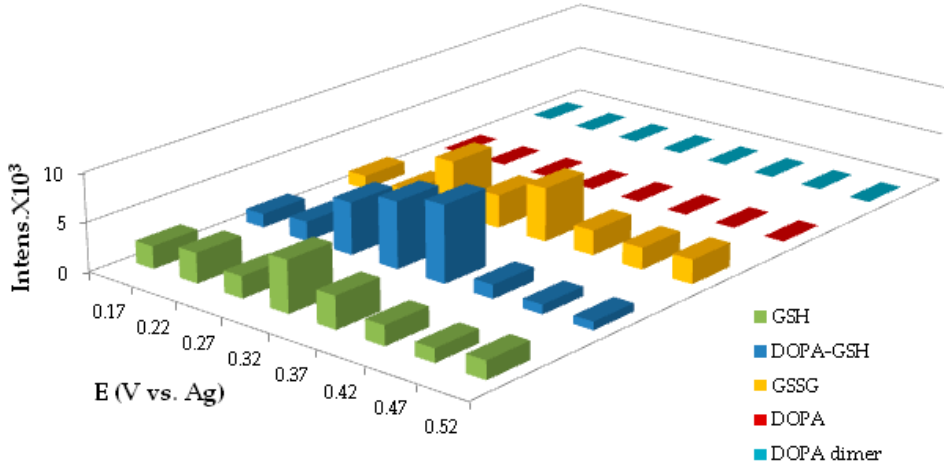
Figure 15. Potential optimization of DOPA electrochemical metabolism within the microfluidic device.